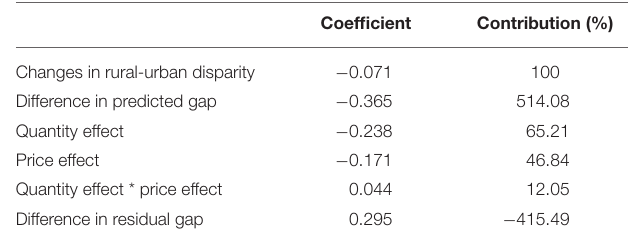
TABLE 3 | JMP decomposition of the change in urban-rural disparity in cognitive